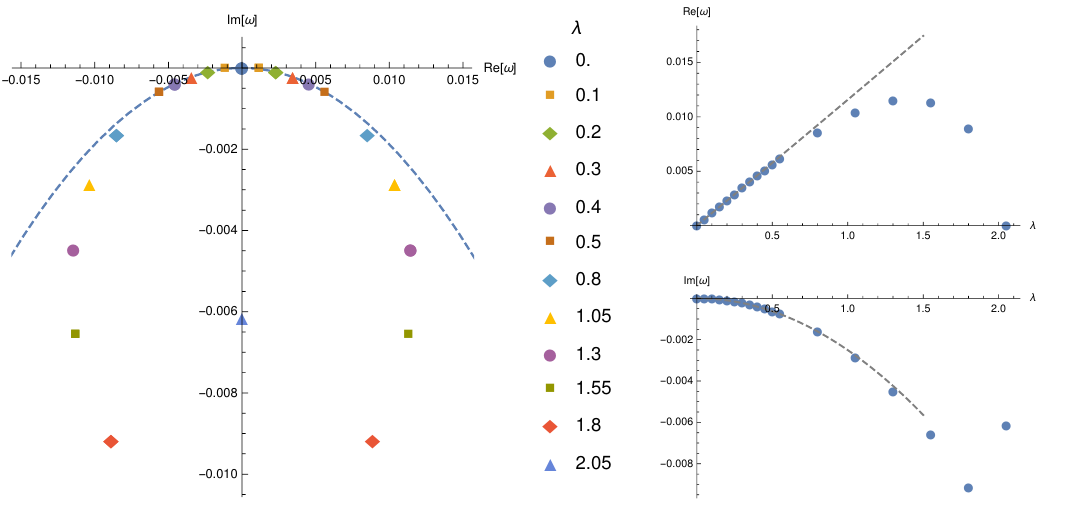
Figure 3 . Dependence of the sound velocity squared on temperature.